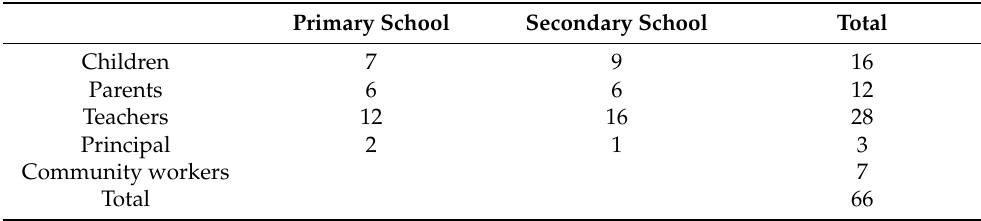
Table 1. Number of each group of participants